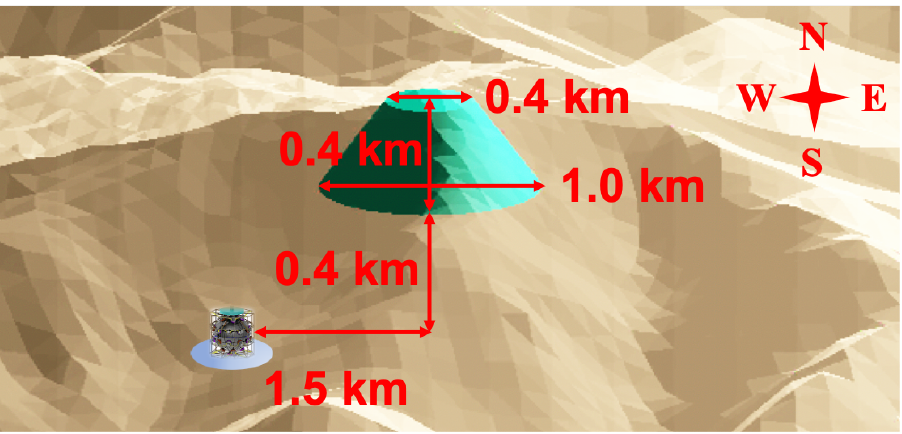
Figure 8. The mountain (grey) with an artificially embedded density variation region (cyan) and its shape and location. The height and diameter of the detector are enlarged 100 times for display convenience. The horizontal distance from the detector to the center of the region is 1.5